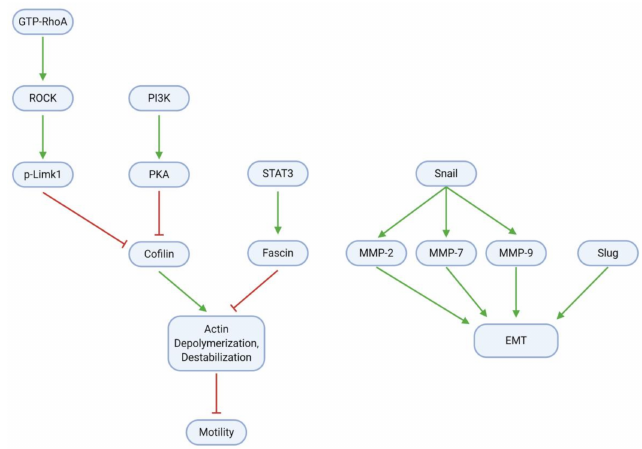
Figure 8. GBM cells gain migration and invasion abilities through EMT and modulation of the cytoskeletal actin framework. Regularization of actin filaments by STAT3/Fascin enhances cell motility; this process is reversible by Cofilin, which in tumor cells is inhibited by RhoA/ROCK/Limk and PI3K/PKA signaling. Upregulation of Snail, Slug, and MMPs further increases motility through EMT induction.